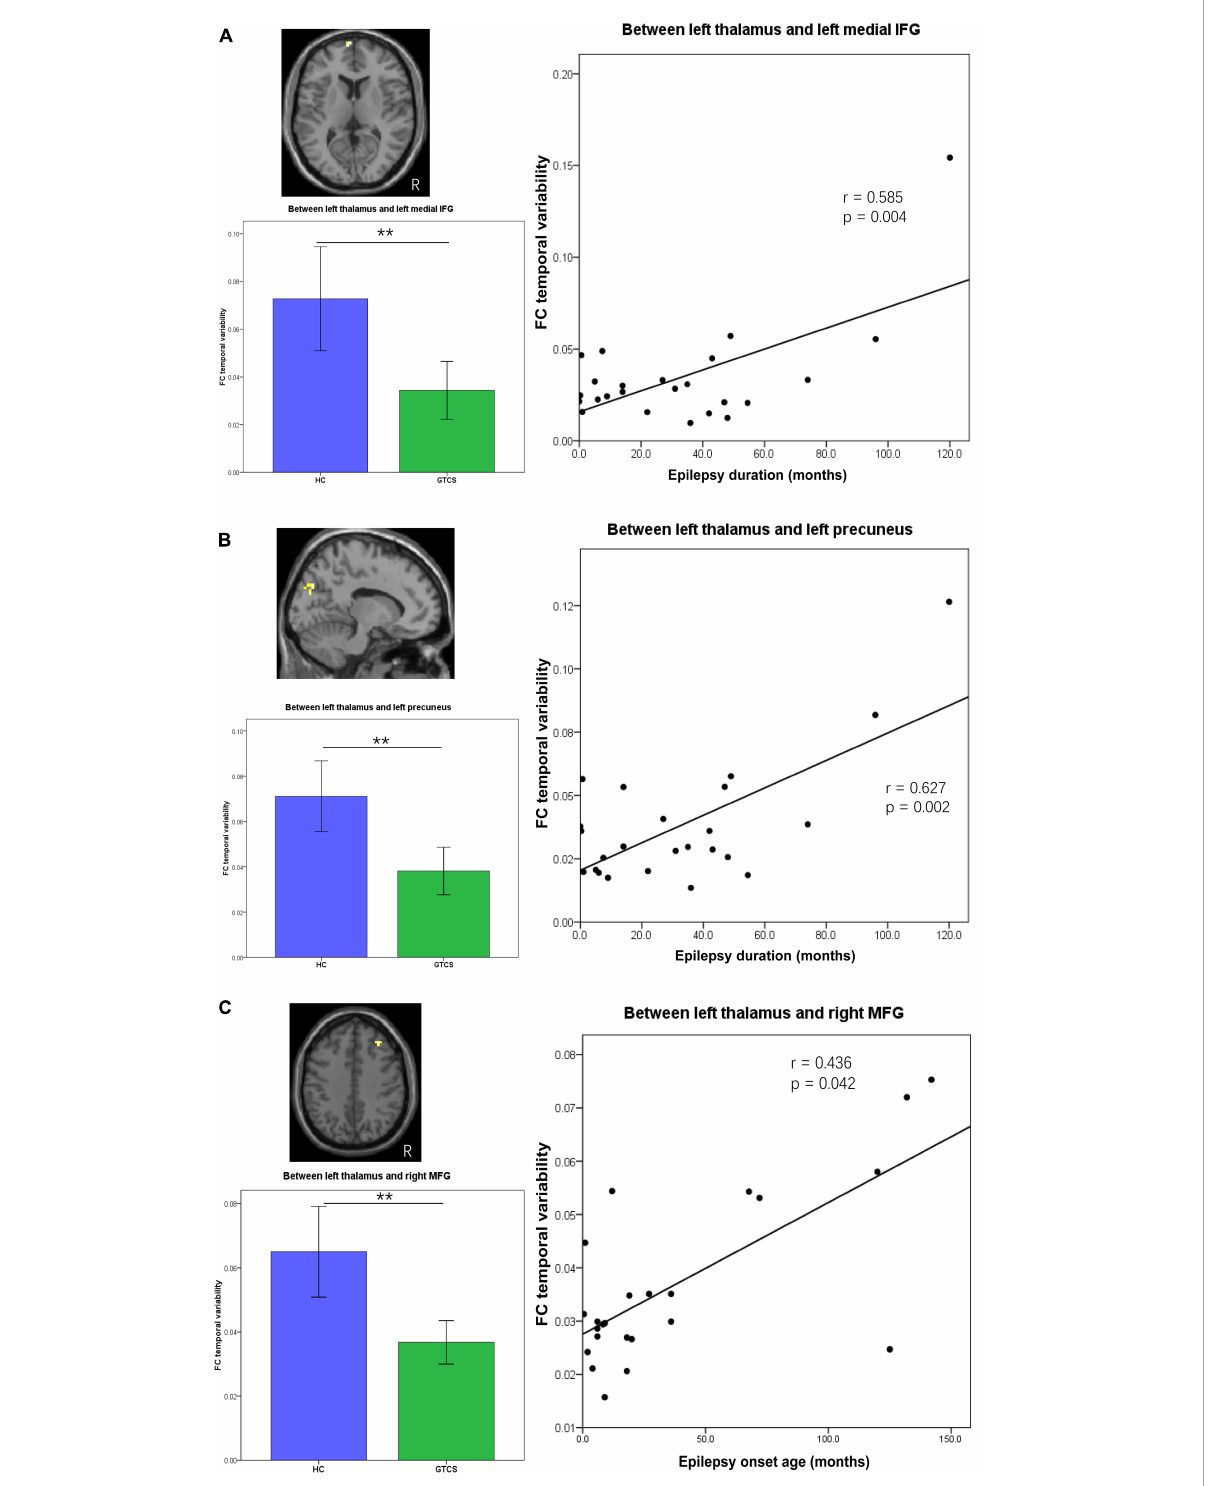
FIGURE5 Partial correlation between connectivity temporal variability and clinical characteristics (epilepsy duration or epilepsy onset age) in children with GTCS. (A) The dFC temporal variability between left thalamus and left medial IFG showed significant correlation with the epilepsy duration ( r = 0.585, p = 0.004). (B) The dFC temporal variability between left thalamus and left precuneus showed significant correlation with the epilepsy duration ( r = 0.627, p = 0.002). (C) The dFC temporal variability between left thalamus and right MFG showed significant correlation with the epilepsy onset age ( r = 0.436, p = 0.042). dFC, dynamic functional connectivity; IFG, inferior frontal gyrus; MFG, medial frontal